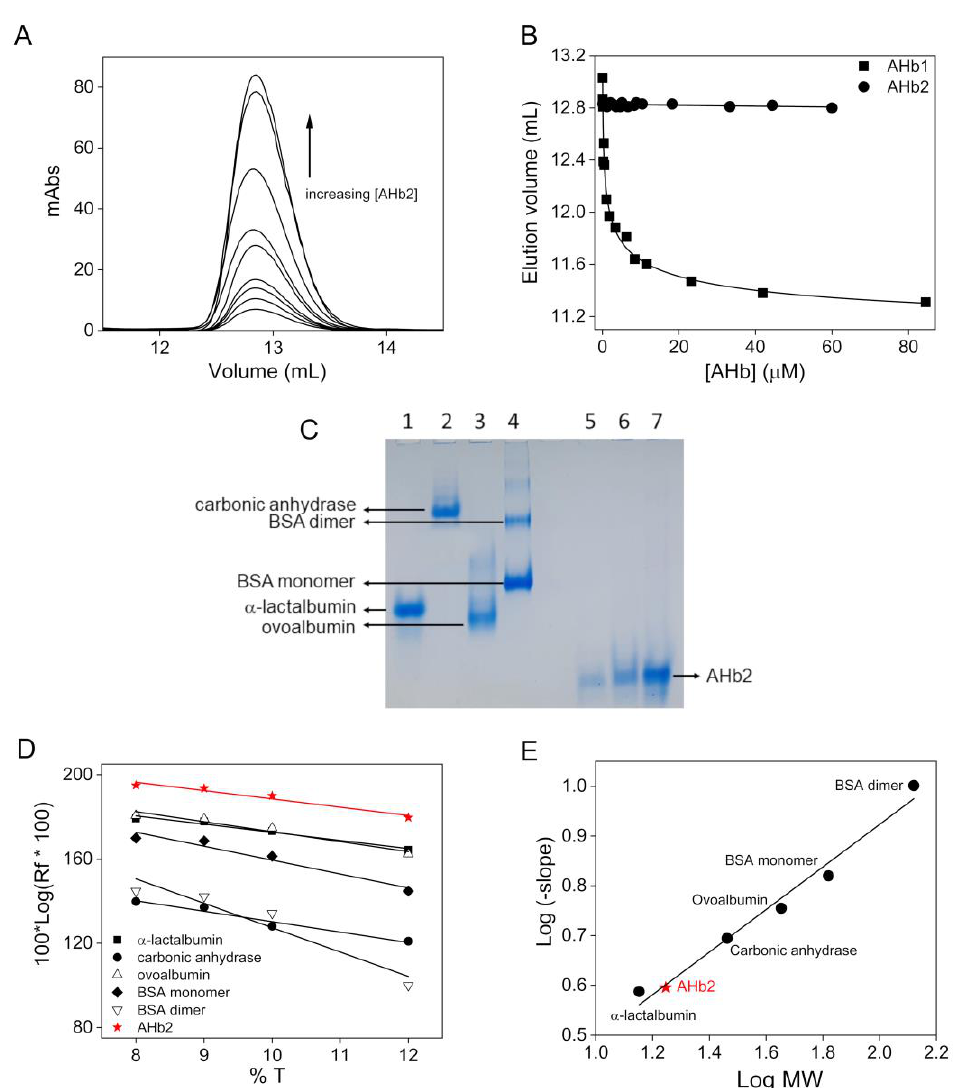
Figure 2. Oligomeric state of AHb2. ( A ) Representative elution profiles of ferric AHb2 on a Superdex-75 Increase 10 / 300 GL column at selected protein concentrations (0.1–60 µ M range). The arrow indicates the direction of shift of the chromatographic peak with increasing protein concentration. ( B ) Comparison of AHb1 and AHb2 elution volumes at di ff erent protein concentrations. ( C – E ) Relative electrophoretic mobility calculation of AHb2 monomer by Ferguson plot. ( C ) Representative native-PAGE (9% T) showing the mobility of standard proteins and AHb2. Lane 1: α -lactalbumin; Lane 2: carbonic anhydrase; Lane 3: ovoalbumin; Lane 4: BSA (dimer and monomer); Lane 5: AHb2 5 µ M; Lane 6: AHb2 10 µ M; Lane 7: AHb2 25 µ M. ( D ) E ff ect of %T on the relative mobility of standard proteins and AHb2. Plot according to Ferguson et al. [30] of 100 [log (Rf · 100)] versus %T. ( E ) Standard curve obtained by plotting the log of the negative slope (from ( D )) against the log of standard proteins molecular weight (MW). The graph was used to determine the apparent MW of AHb2 (red five-pointed star).